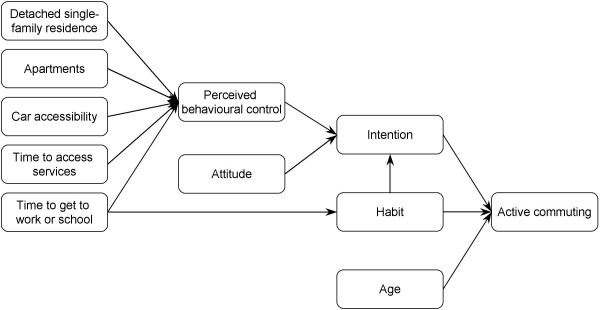
Observed model for the prediction of active commuting. Only significant associations are illustrated.